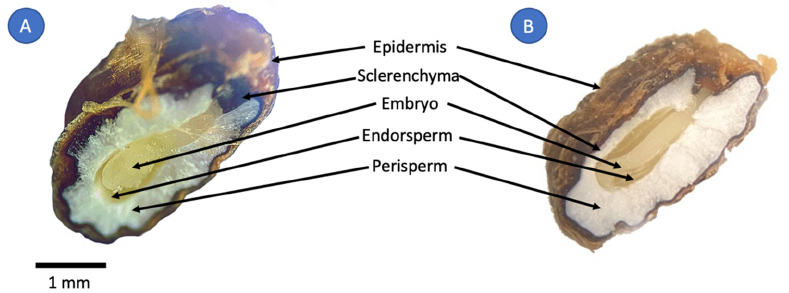
Figure 1. Cardamom seed morphology: ( A ) Untreated cardamom seed ( B ) DIC-treated cardamom seed (140 °C and 30 s).